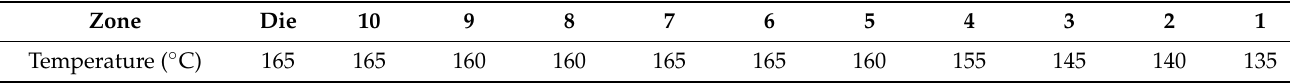
Table 3. Compounding temperature